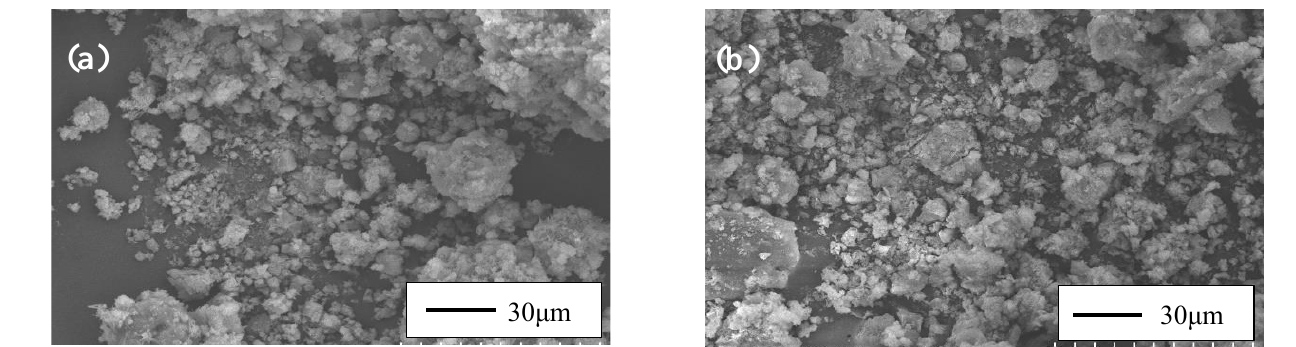
Figure 7. SEM images of RMSWIFA ( a ) and TMSWIFA ( b